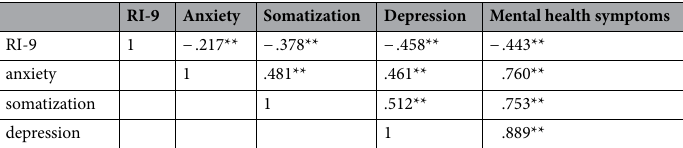
Table 5. Correlation between RI-9 and other variables. * p < .05, ** p < .01.